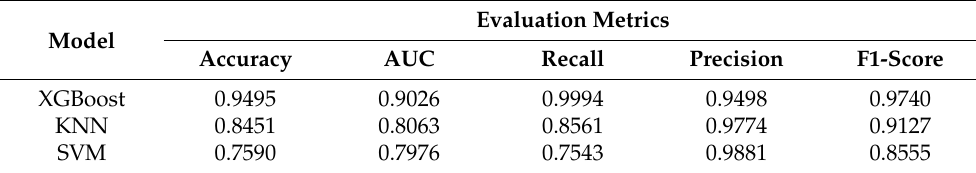
Table 11. XGBoost model versus traditional machine learning models.